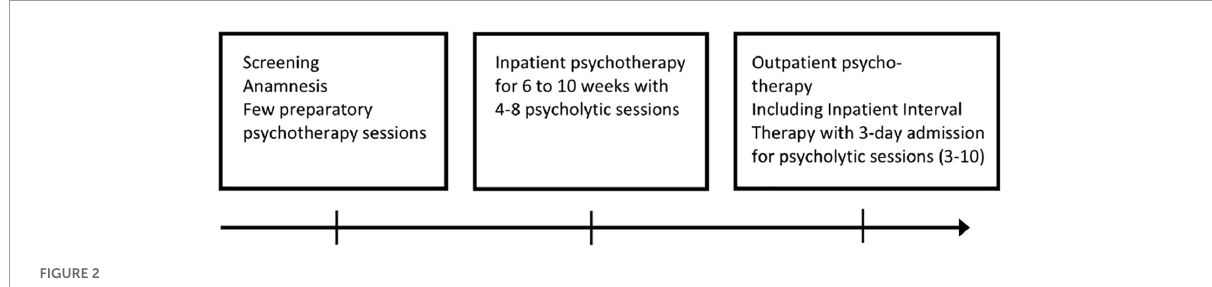
FIGURE2 Overview of the psycholytic therapy treatment